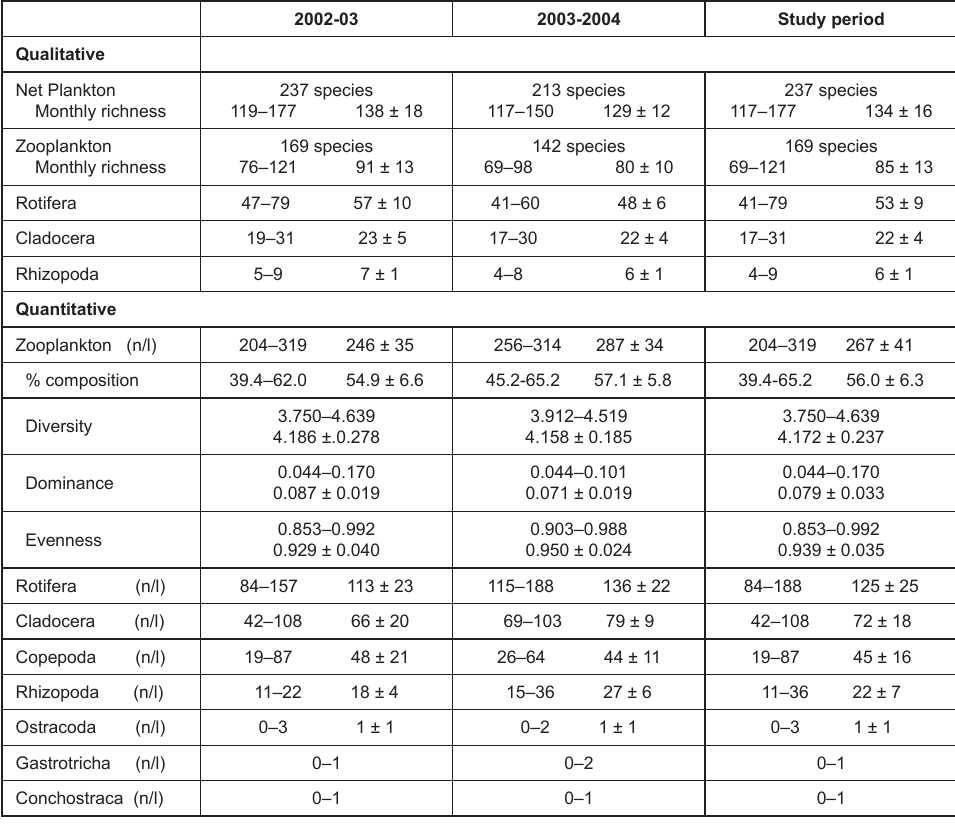
Table 2. Temporal variations of Zooplankton of Loktak